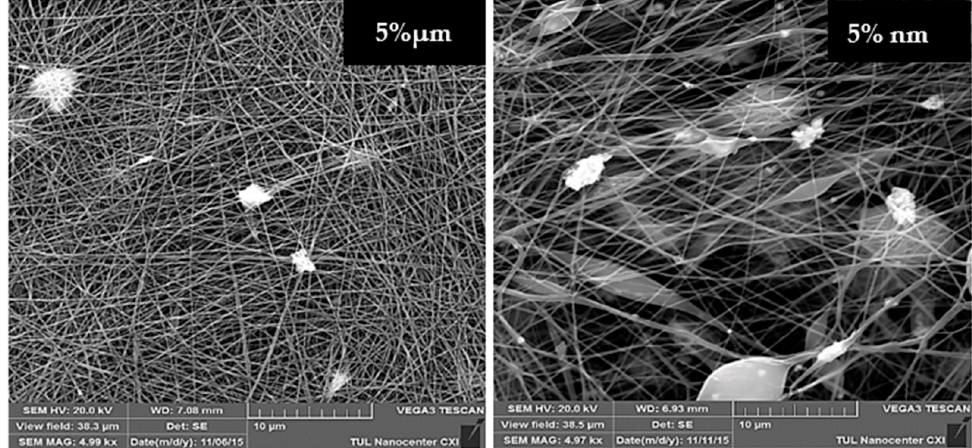
Figure 6. SEM images (5000 × magnification) of nanofibres produced from the wire electrode with 5% of micro- and nanoparticles of CuO respectively.